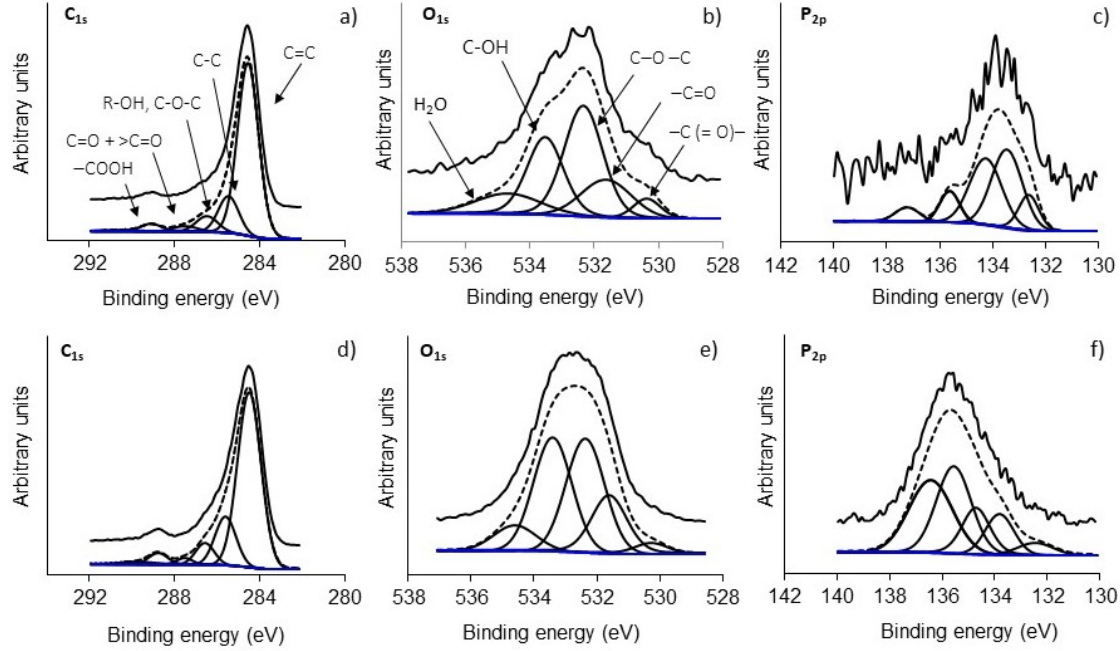
Figure 6. XPS high-resolution spectra of ( a ) C 1s , ( b ) O 1s and ( c ) P 2p regions for P500 and ( d ) C 1s , ( e ) O 1s , and ( f ) P 2p regions for P600.